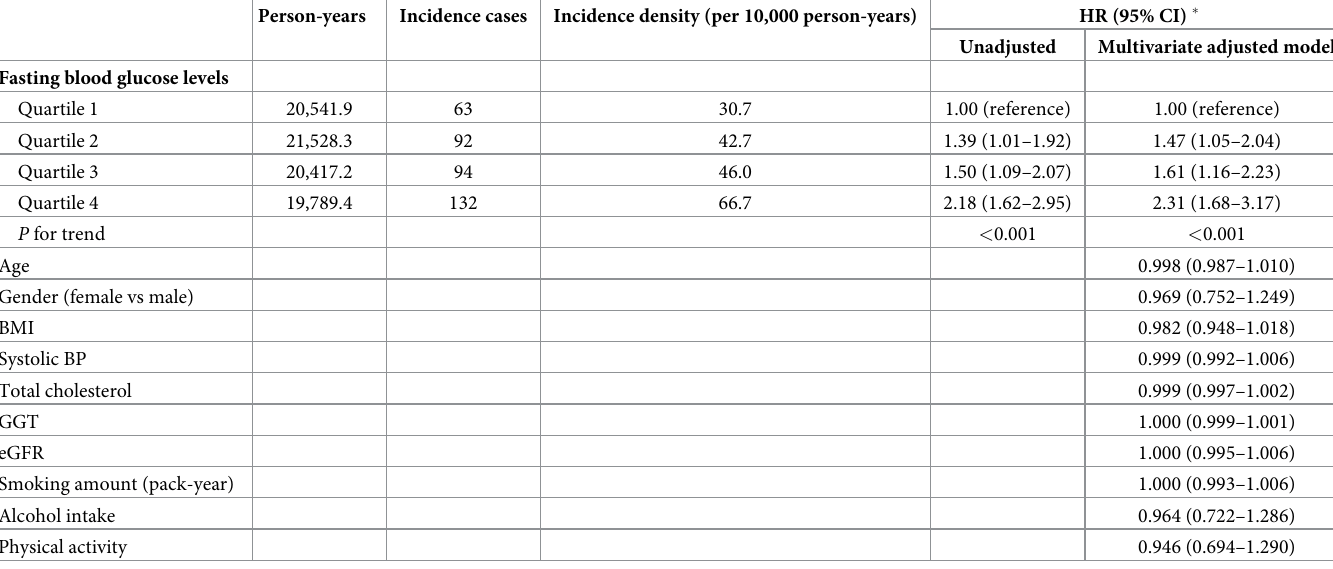
Table 2. Hazard ratios (HRs) and 95% confidence intervals (CI) for the incidence of pancreatic cancer according to the quartile groups of fasting blood glucose